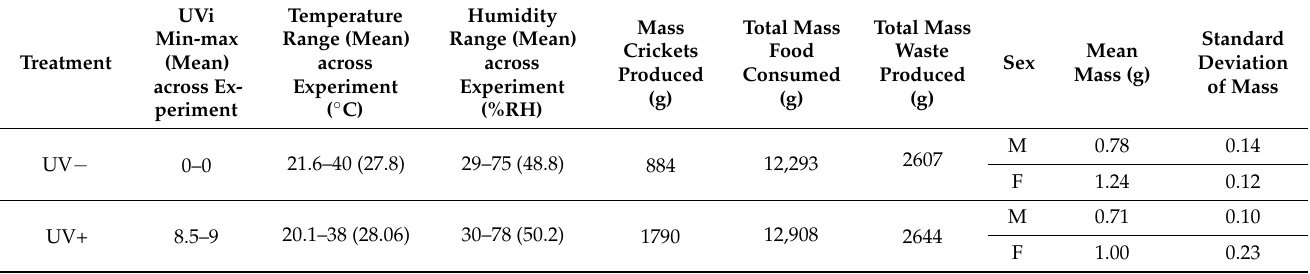
Table 1. Environmental parameters and cricket performance data from UV − and UV+